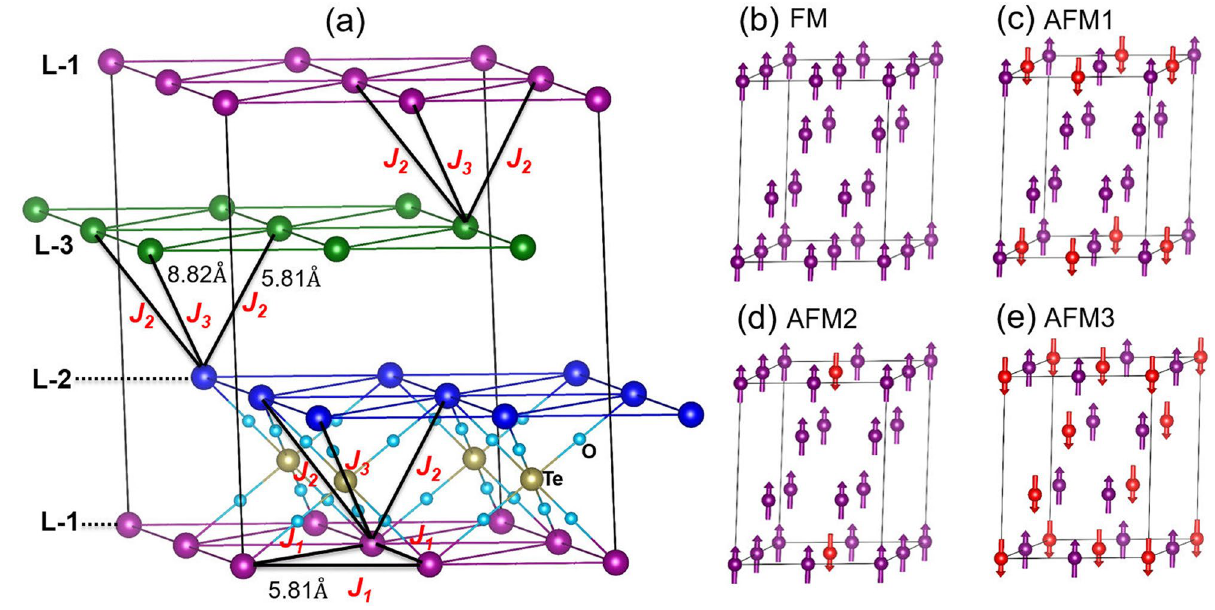
Figure 8. ( a ) The dominant exchange interaction paths J 1 , J 2 and J 3 for the Mn spins in the layered compound BMTO. J 1 represents the in-plane nearest neighbor (5.81 Å) exchange interaction, while J 2 and J 3 correspond to out-of-plane nearest and next-nearest interactions with Mn-Mn separations at 5.81 Å and 8.22 Å, respectively. The J 1 forms a triangular lattice in the plane. To estimate the strengths of the J i ’s, several total energy calculations were carried out on four spin arrangements, defined as FM, AFM1, AFM2, and AFM3 ( b – e